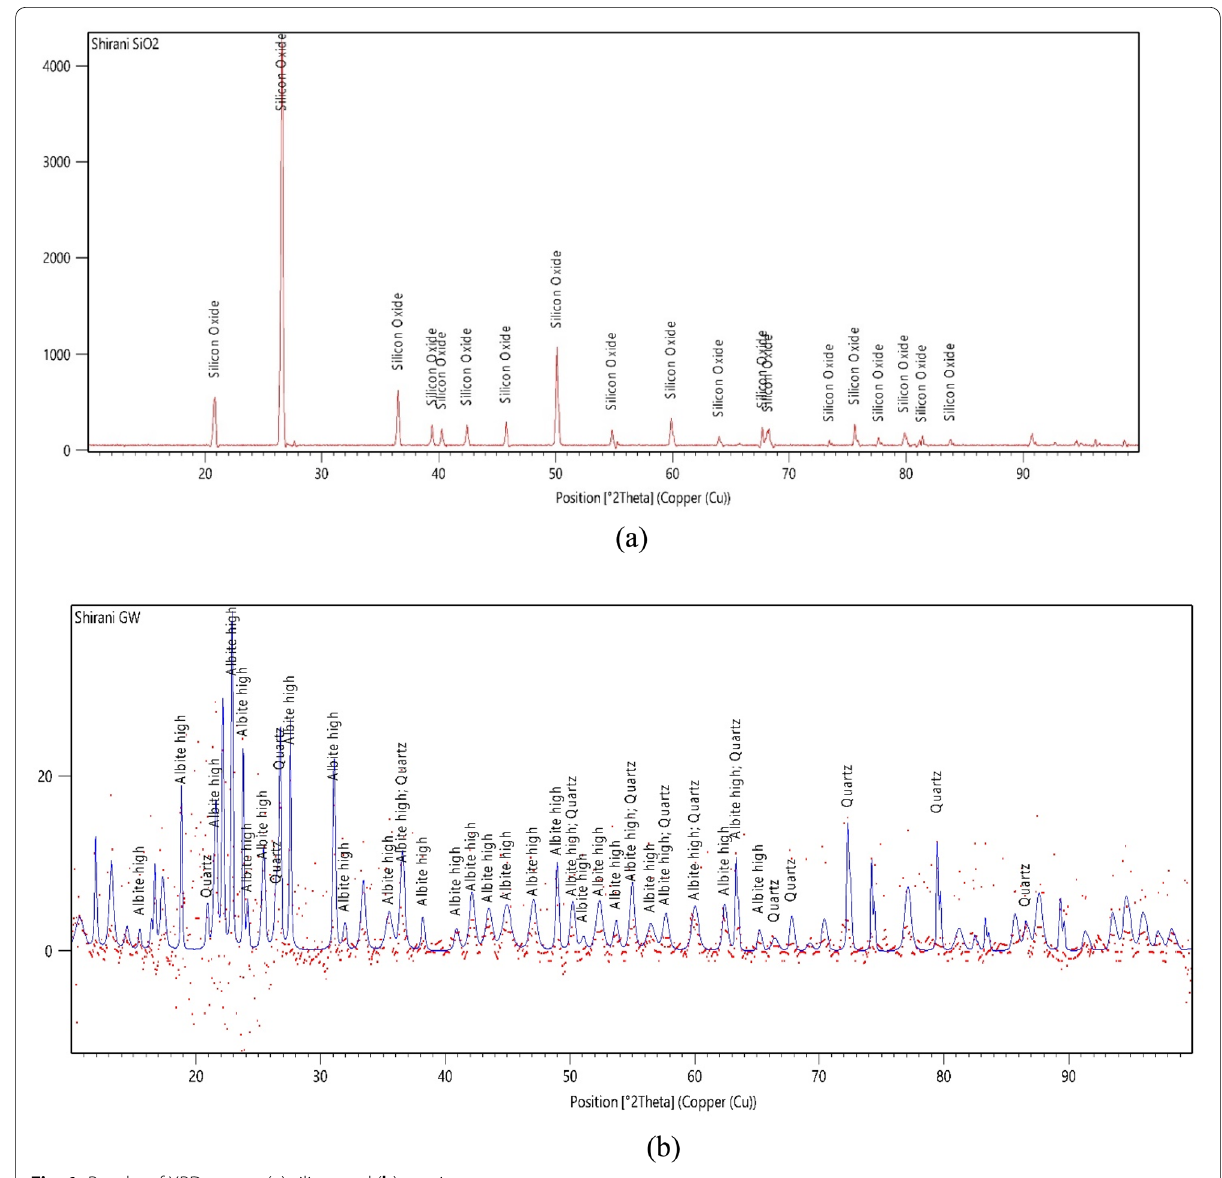
Fig. 1 Results of XRD test on ( a ) silica sand ( b ) granite